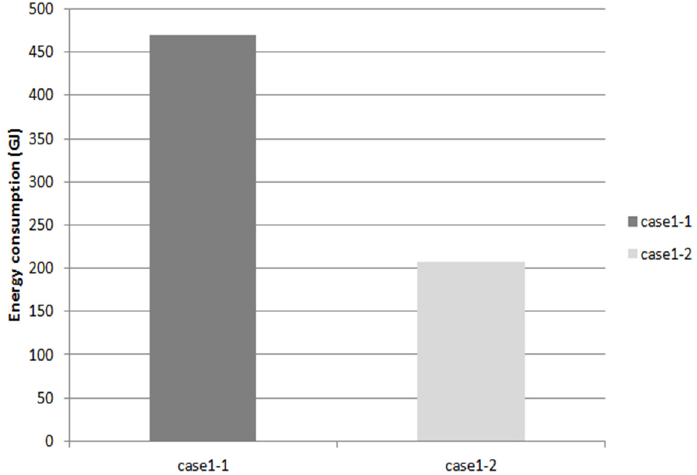
Figure 17. Comparison of the energy consumption for the Multi-GHP system: Case 1-1: existing operation condition of the Multi-GHP system; Case 1-2: sequencing operation condition of the Multi-GHP